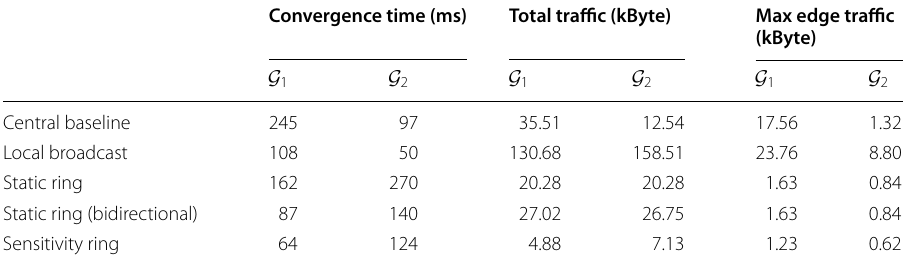
Table 2 Comparison of the different neighbor selection strategies with the central baseline